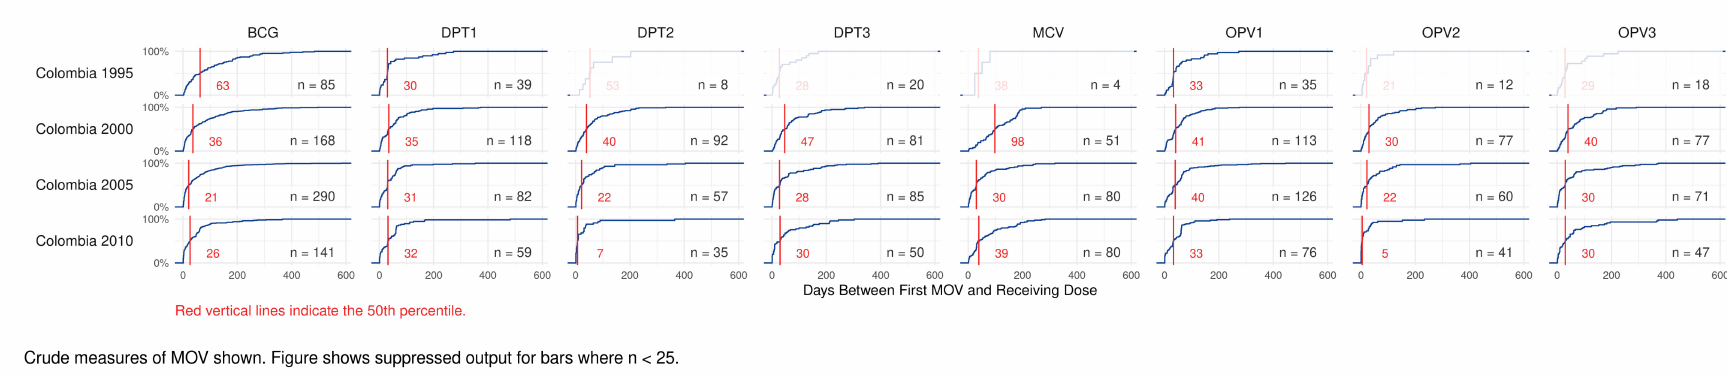
Figure 7. Cumulative distribution of time to MOSV correction, in days, by dose, Colombia, 1995–2010. Additional quantiles for Colombia are documented in supplementary Table SC.5a and subnational detail is in Table